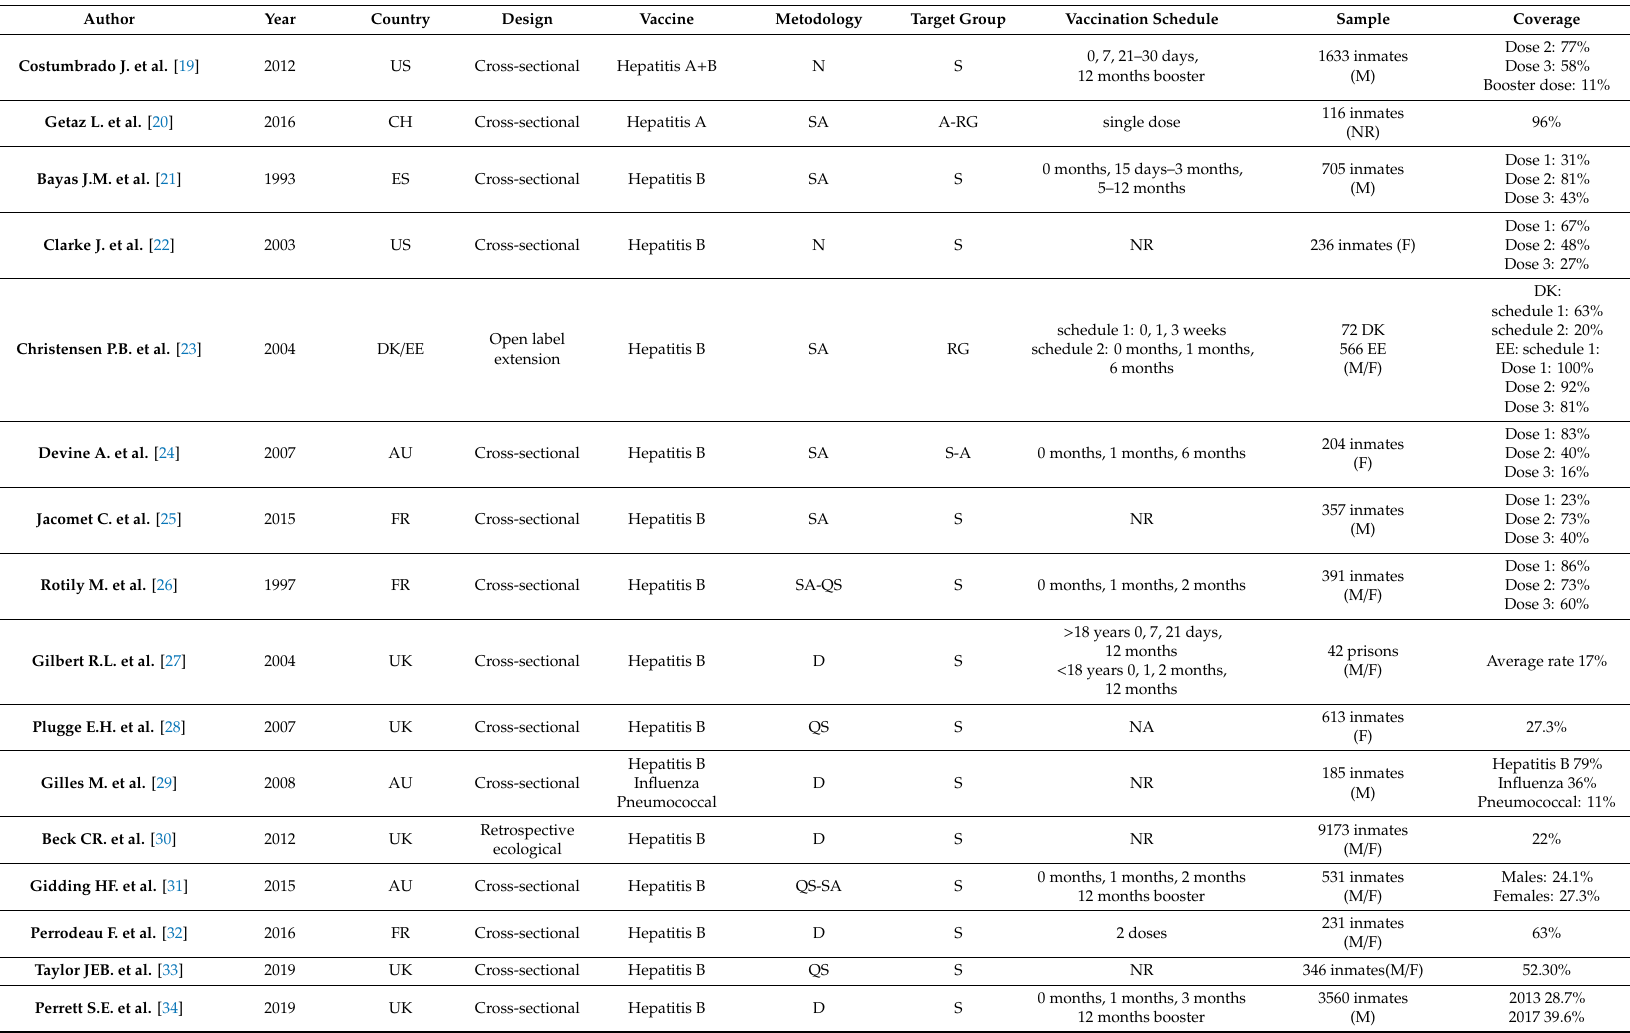
Table 1. Characteristics of included